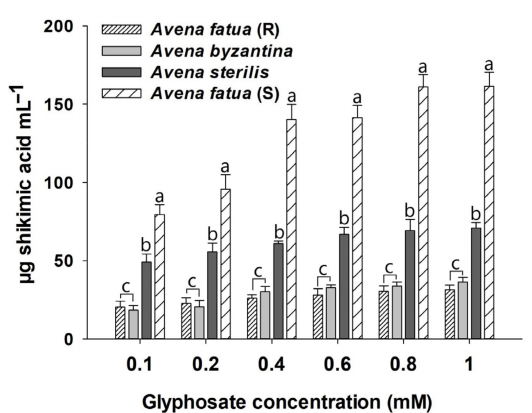
Figure 4. Shikimic acid accumulation in leaves of the four Avena accession. Vertical bars are the standard errors of the means ( n = 6). Different letters correspond to different groupings according to Tukey’s HSD test ( p <